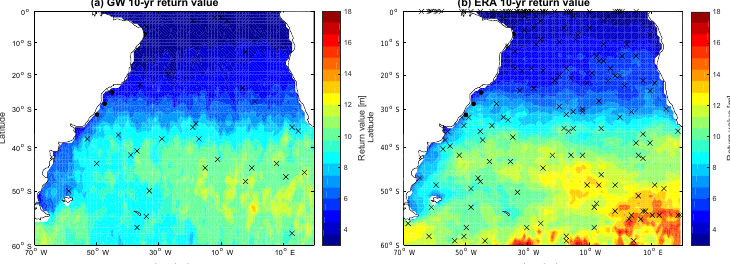
Figure 7. Distribution of 10-year return values from interpolated LOS data (a) and from ERA-Interim (b) in the South Atlantic. Crosses represent the series that did not pass the Kolmogorov–Smirnov test.